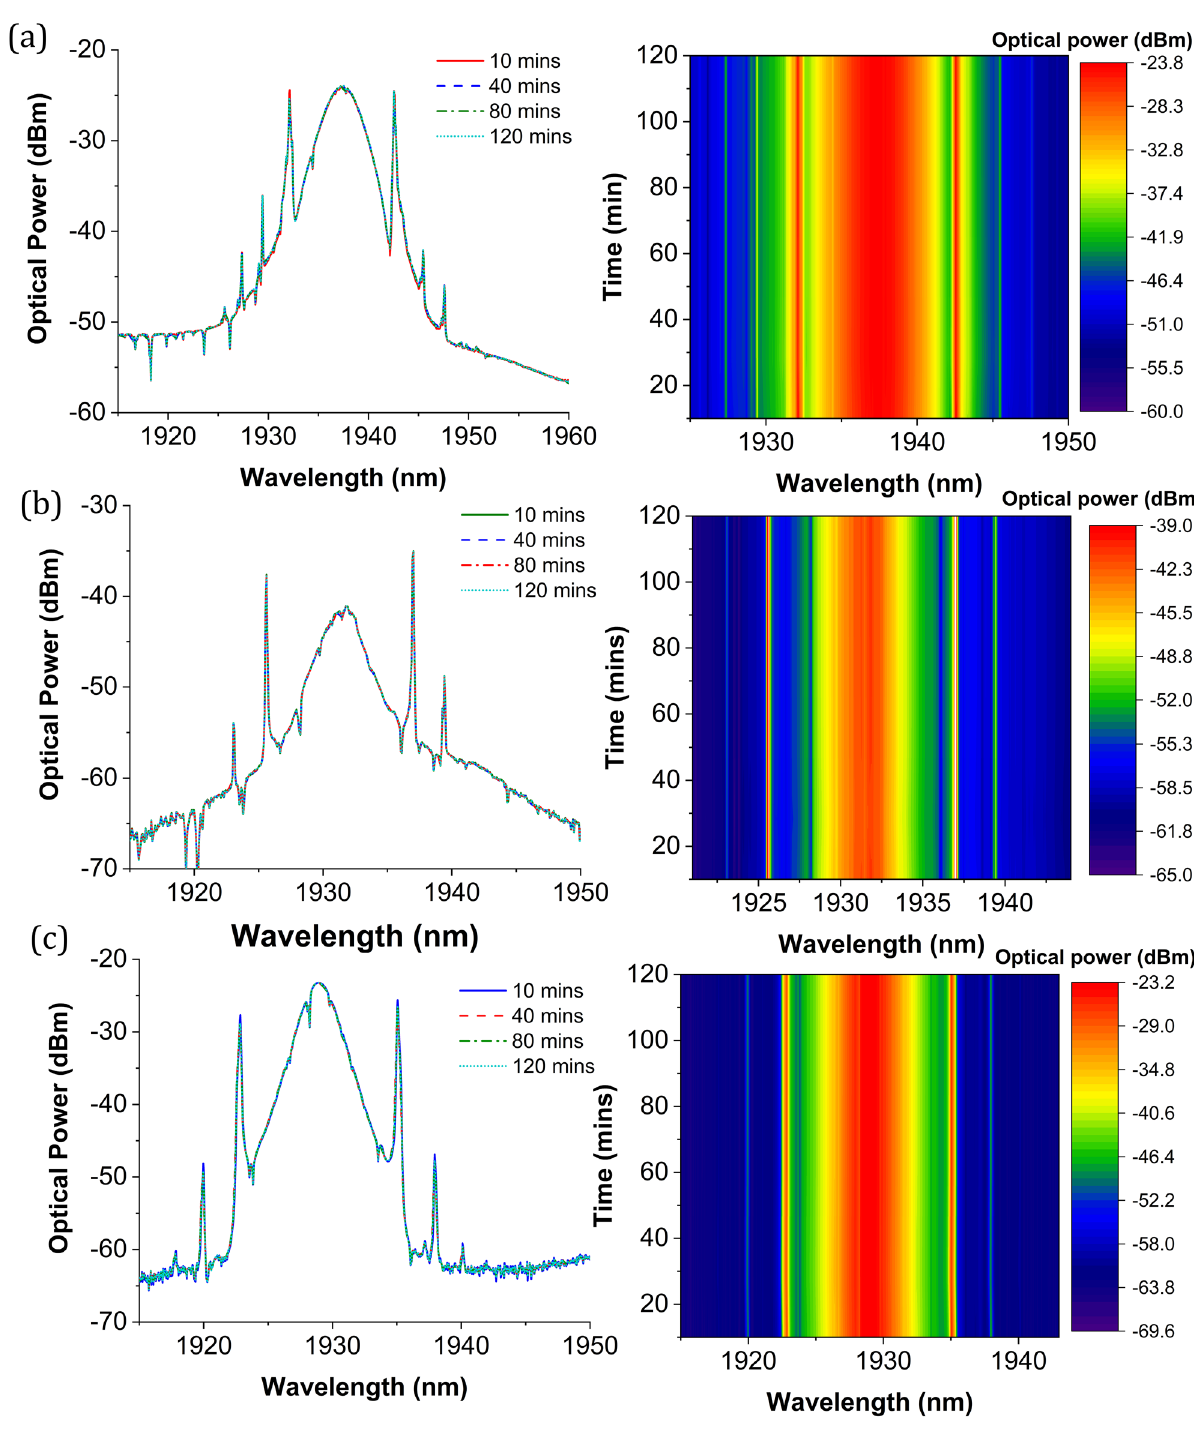
Figure 14. The stability of the output pulse spectrum for Ta 2 AlC and the corresponding contour plot for ( a ) tapered fiber, ( b ) SPF, and ( c ) arc-shaped fiber saturable absorber. The stability test was conducted for two hours at a 10-min